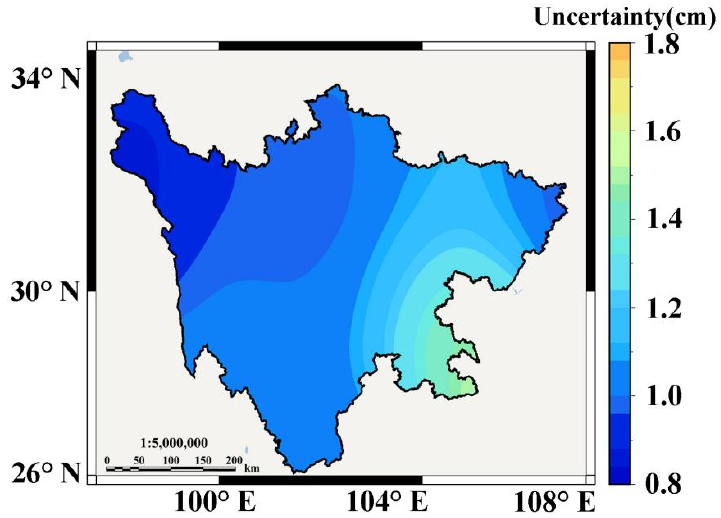
Figure 3. The spatial distribution of uncertainties of the TWSC results derived from the fused re- sults.